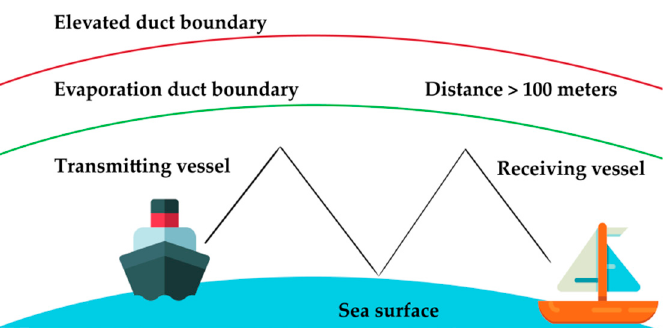
Figure 10. Vessel-to-vessel communication scenario for the channel model.